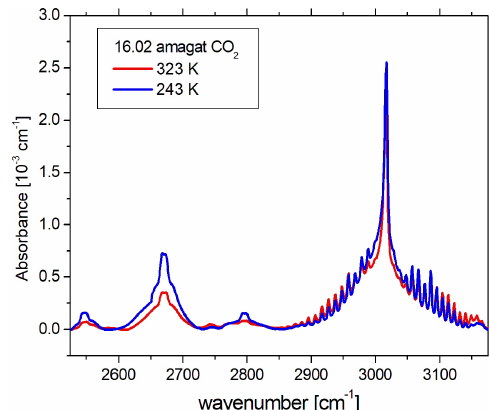
Figure 10. The absorption spectra of 16.03amagat of carbon diox- ide at 243 and 323K, recorded with PASS x S, after subtraction of the strong contributions of the ν 3 fundamental band at 2350cm − 1 and a weaker Fermi doublet ( ν 3 + ν 1 , ν 3 + 2 ν 2 ) around 3700cm − 1 , as well as contributions of the 16 O 12 C 18 O